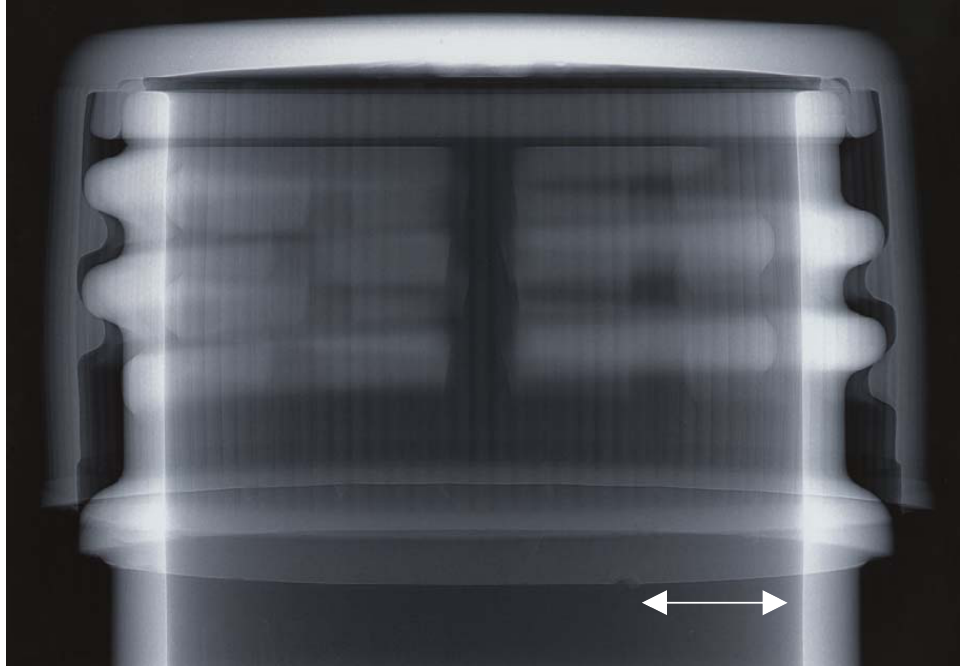
Figure 2. PCX image of the top of a plastic bottle, including cap: 30 kVp, 50 μ